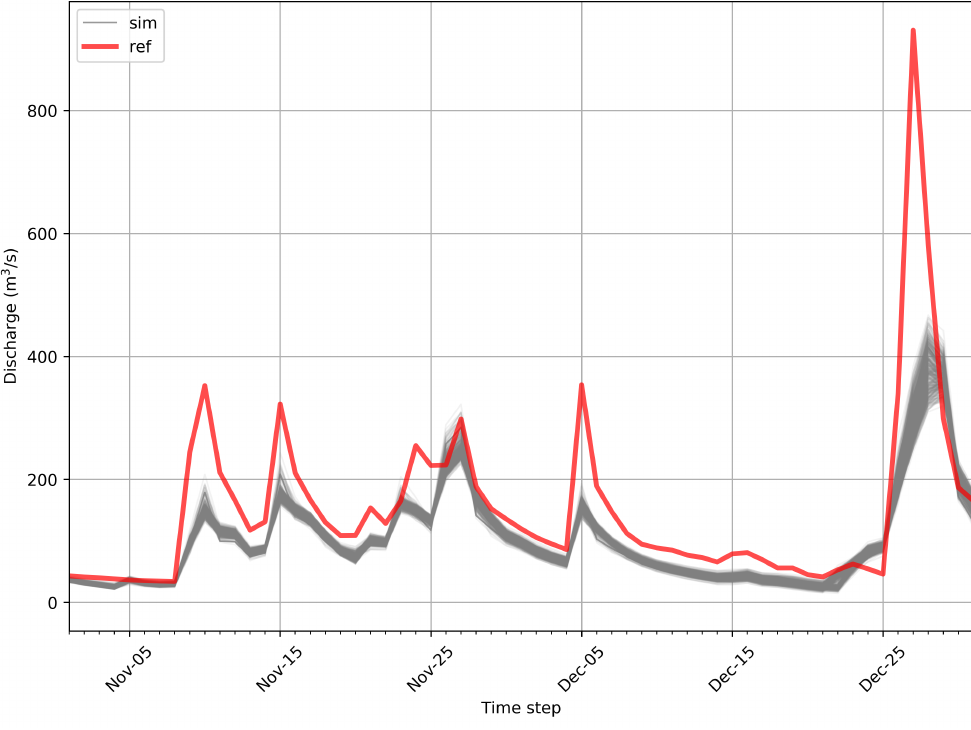
Figure 6. Observed (red) and calculated (gray) discharges for November and December 1882 using the interpolated precipitation and 441 different parameter